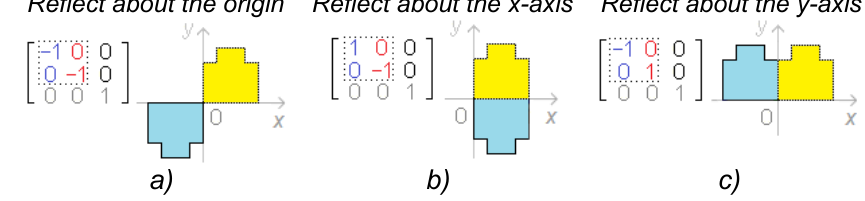
Figure 4 – Three types of reflection transformation matrices and the results of their impact on the chest